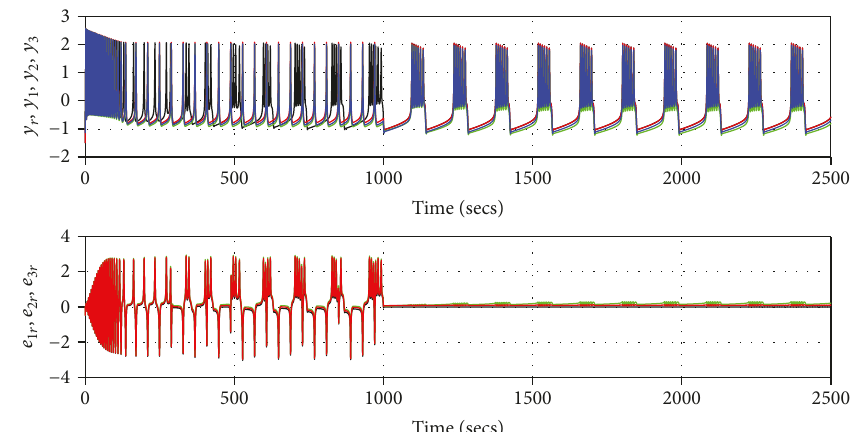
Figure 10: Outputs y